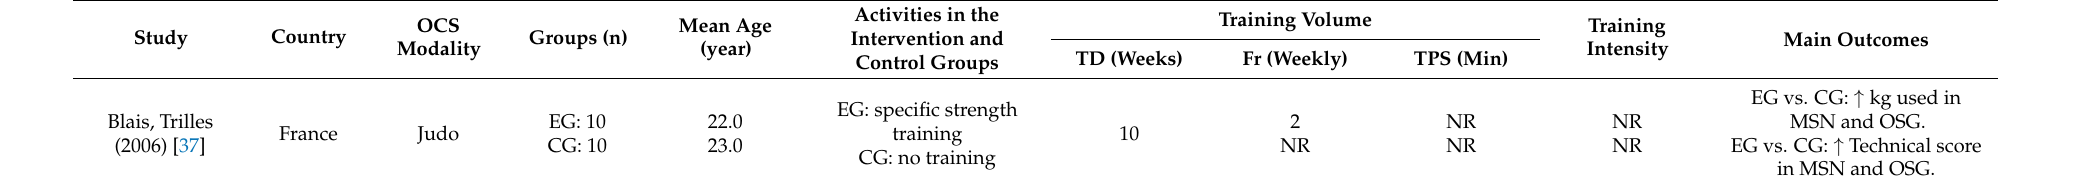
Table 2. Characteristics and effects of studies about muscle strength training in Olympic combat sports.